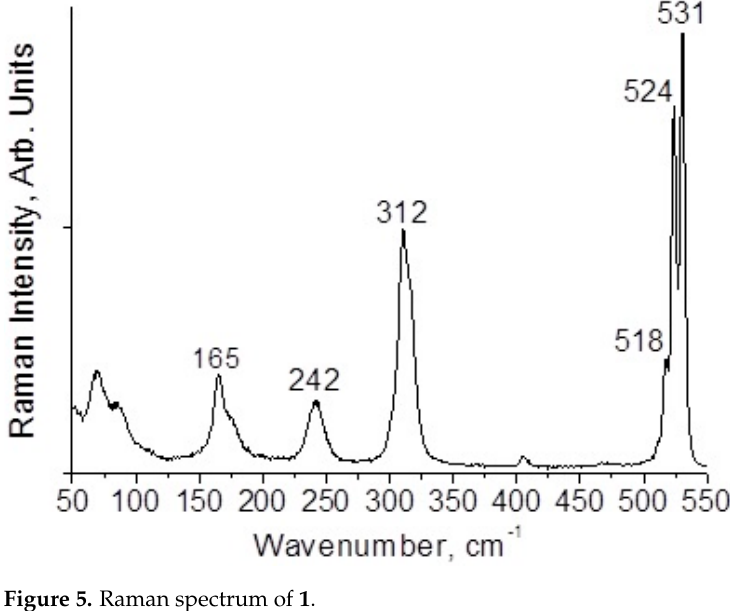
Figure 5. Raman spectrum of 1 .